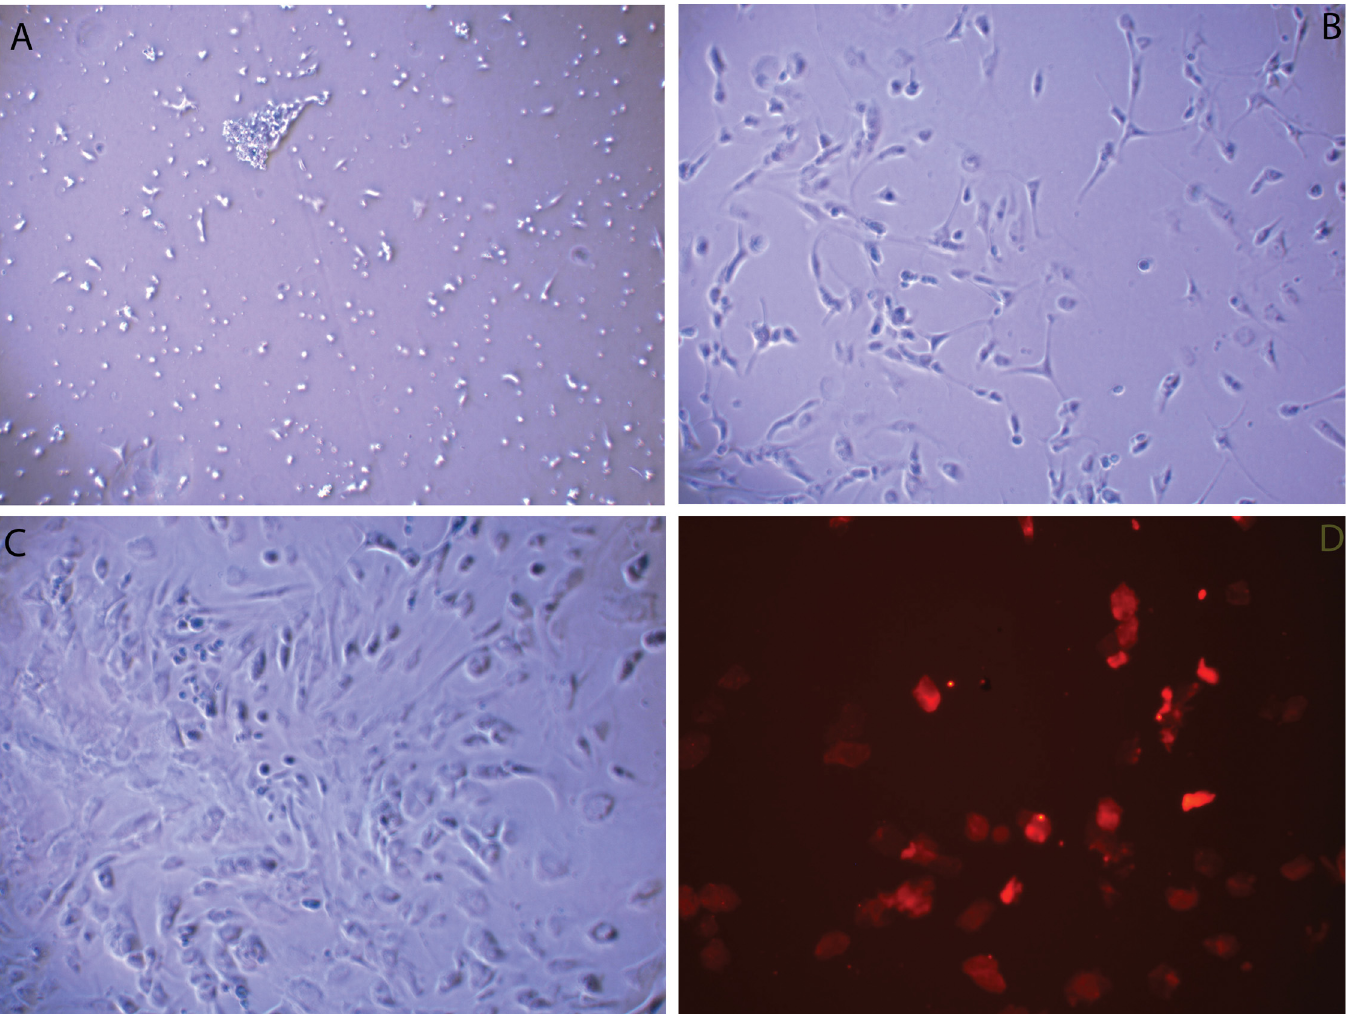
Fig 2. Culture and identification of primary RBMECs. (A) Circular RBMECs were seen at the moment of inoculation. (B) Four days after inoculation, adherent, coupled and proliferated growth of RBMECs was seen. (C) Seven days after inoculation, the RBMECs tended to fuse together. (D) To identified the primary RBMECs, we used anti-vWF (1:200) as a marker; the cytoplasm of primary RBMECs is wholly stained in red. To observe the RBMECs, cells were inspected at 100 × magnification.